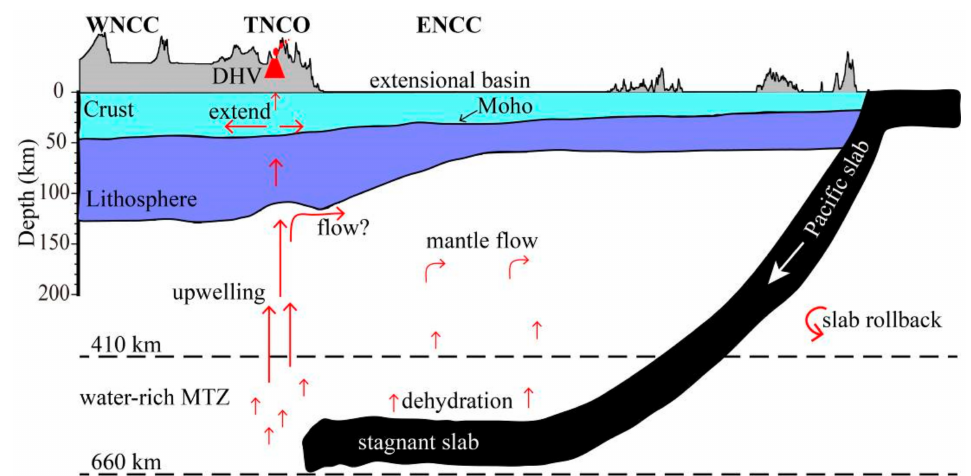
Figure 10. Tectonic sketch map for the lithospheric thinning of the NCC [12,16]. The abbreviations of geological units are defined in the caption of Figure